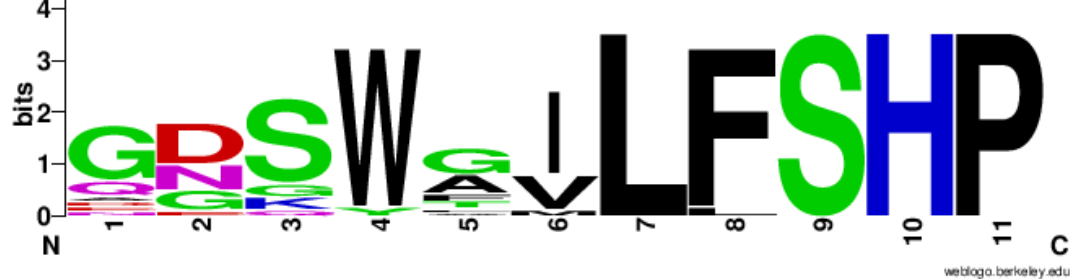
Figure 2. Graphical representation of residue conservation in the putative lysosomal target sequence. The letter size represents the conservation of each residue, while their color represents the chemical property of the corresponding amino acid. Polar amino acids Gly (G), Ser (S), Thr (T), Tyr (Y), Cys (C) are depicted in green; neutral amino acids Gln (Q) and Asn (N) are in magenta; basic amino acids Leu (L), Arg (R), His (H) are in blue; acidic amino acids Asp (D) and Glu (E) are in red; hydrophobic amino acids Ala (A), Val (V), Leu (L), Ile (I), Pro (P), Trp (W), Phe (F), Met (M) are in black. The logo was generated with the WebLogo application (http://weblogo.berkeley.edu).